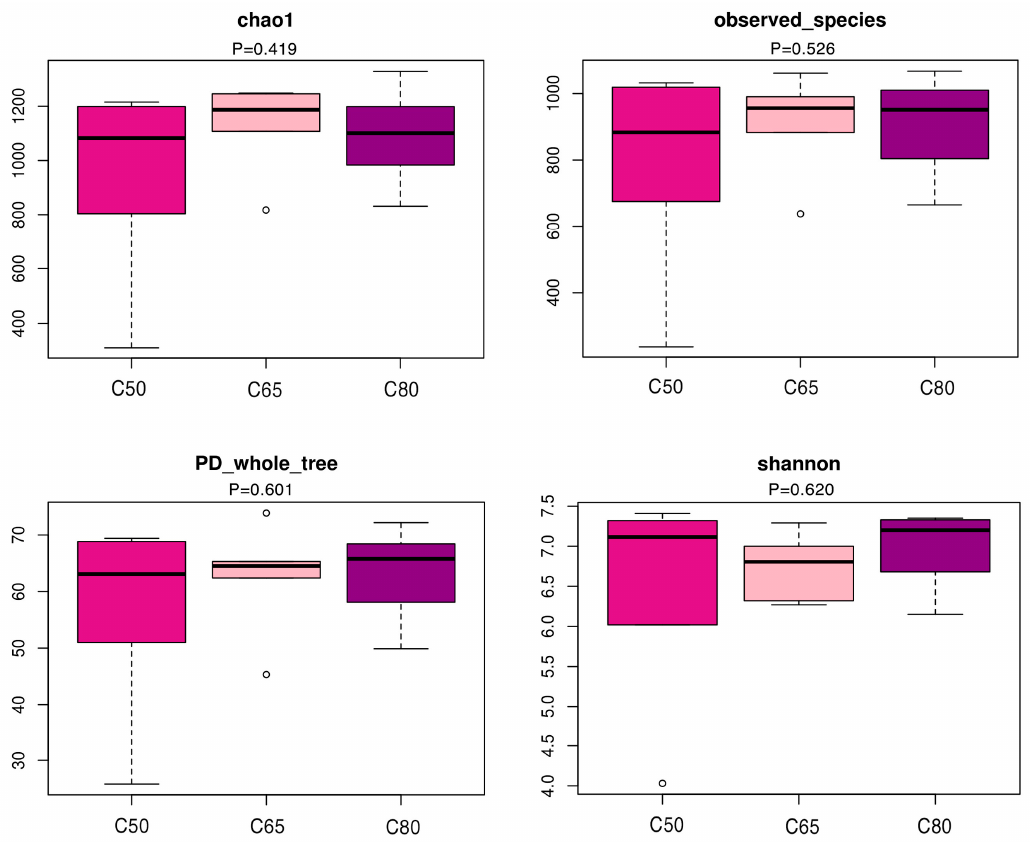
Figure 2. Effect of three diets of concentrate-to-forage ratio on the diversity of fecal microbiota of yaks. p < 0.05 was considered a significant difference.